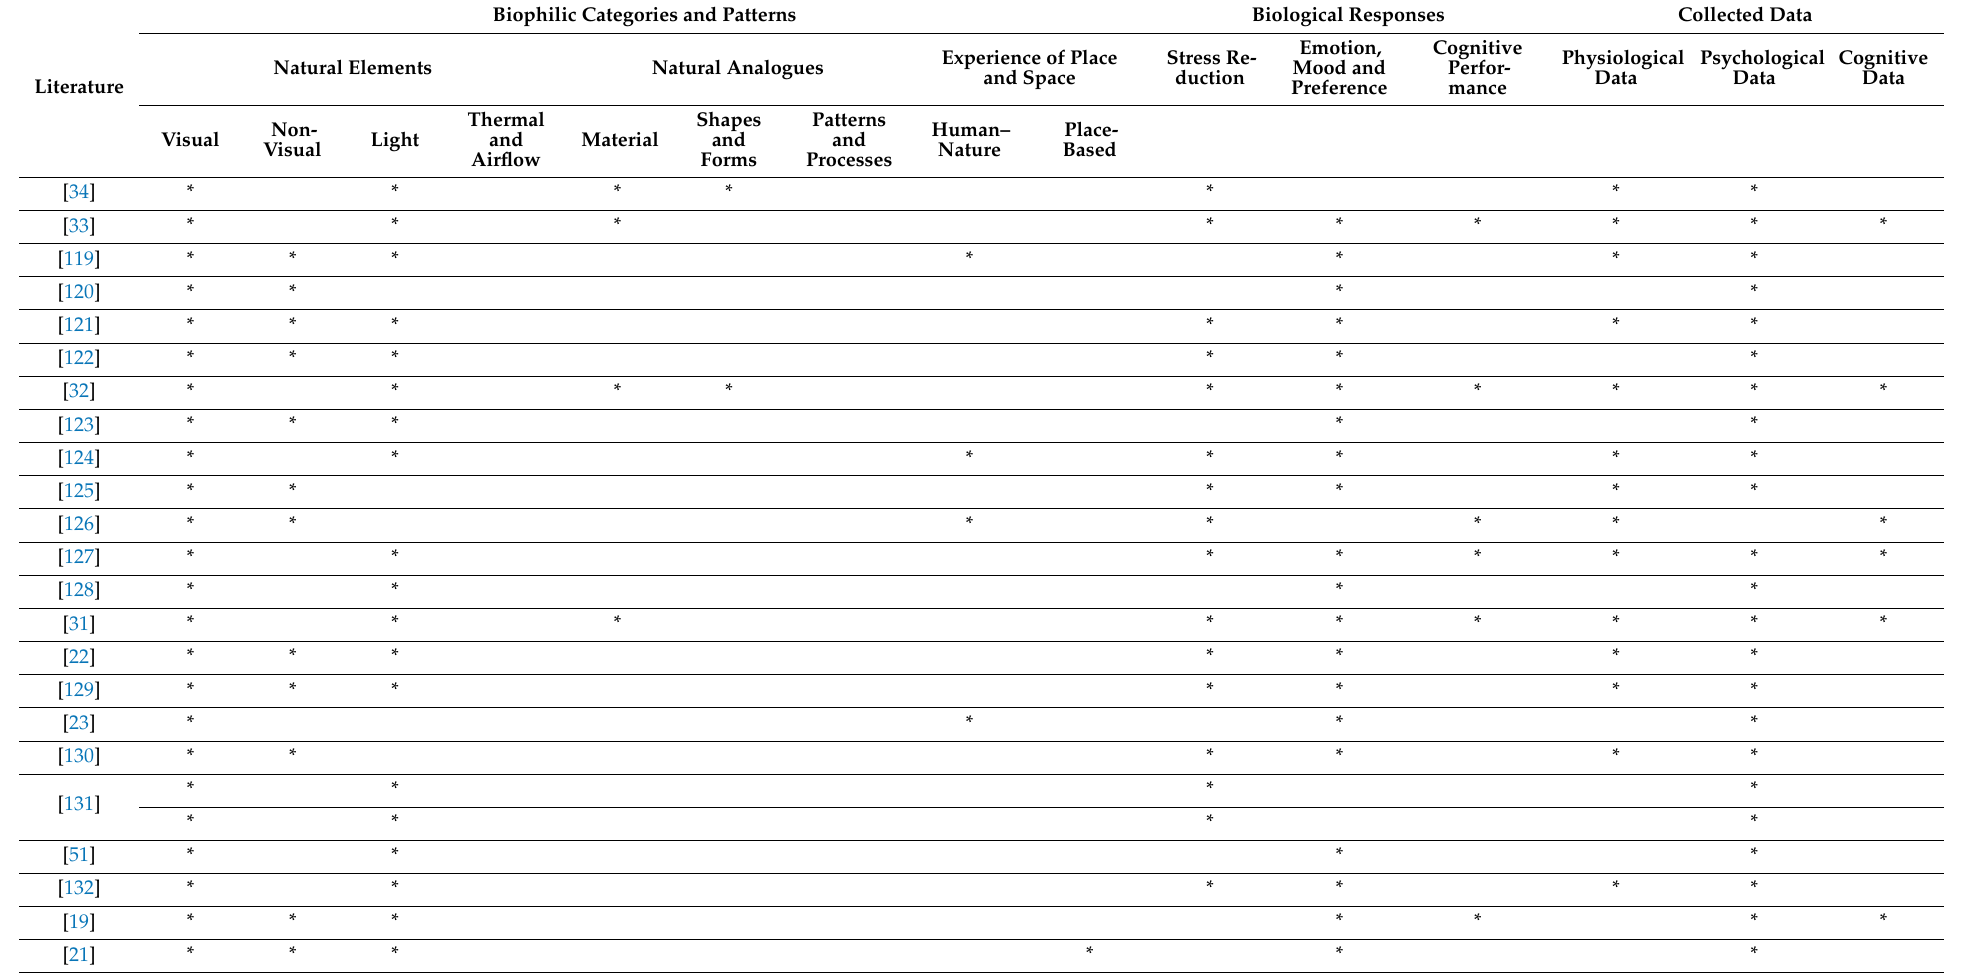
Table A1. Classification of the reviewed studies employing virtual natural environment (factors